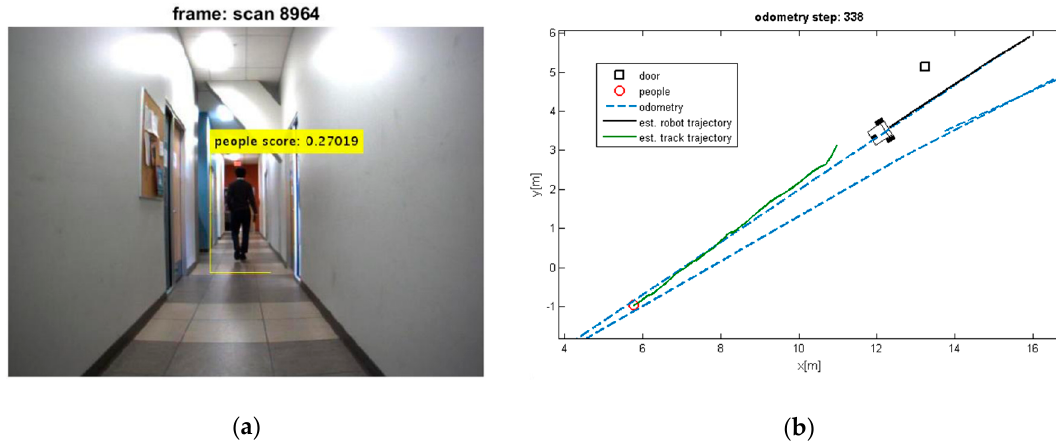
Figure 8. ( a ) Detected moving people; ( b ) Estimated trajectories of the robot and the tracks along with the estimated position of the doors.